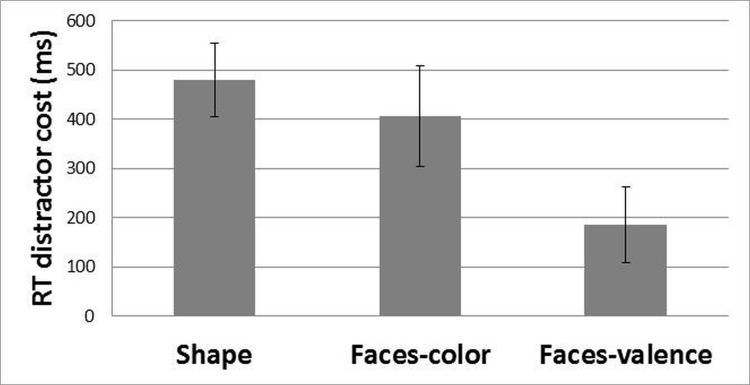
RT distractor cost for the shapes, faces-color and faces-valence tasks.Error bars indicate 95% confidence intervals. Non-overlapping confidence intervals indicate significant difference between the mean scores.